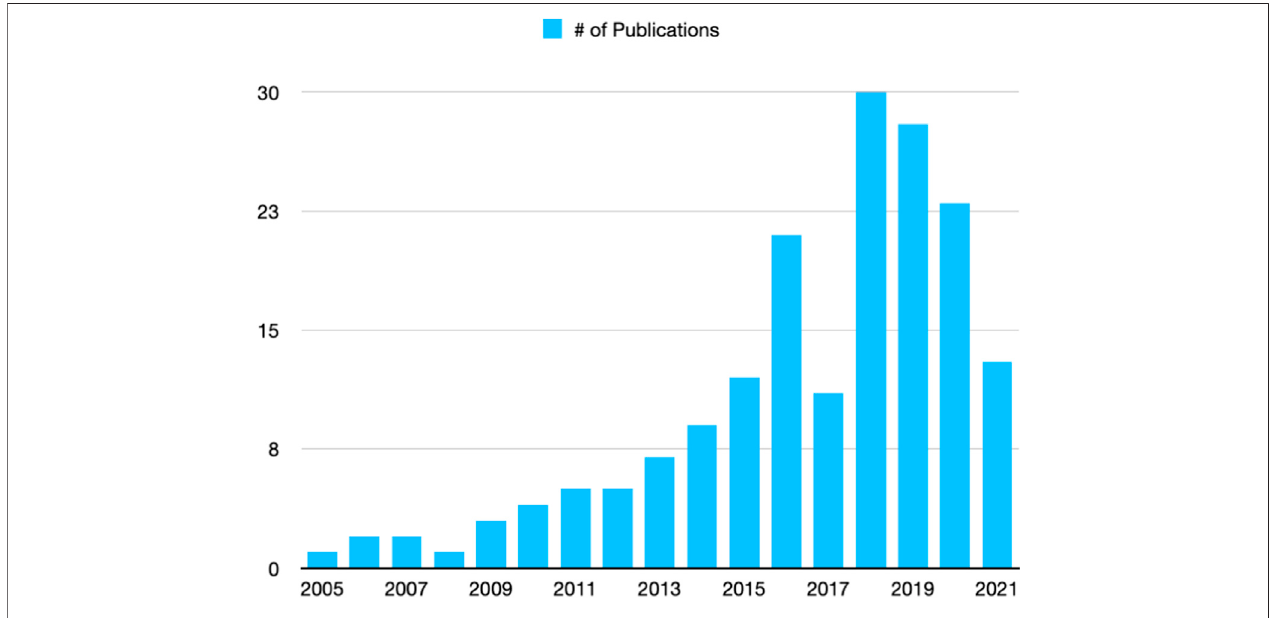
FIGURE 1 | Number of publications collected by